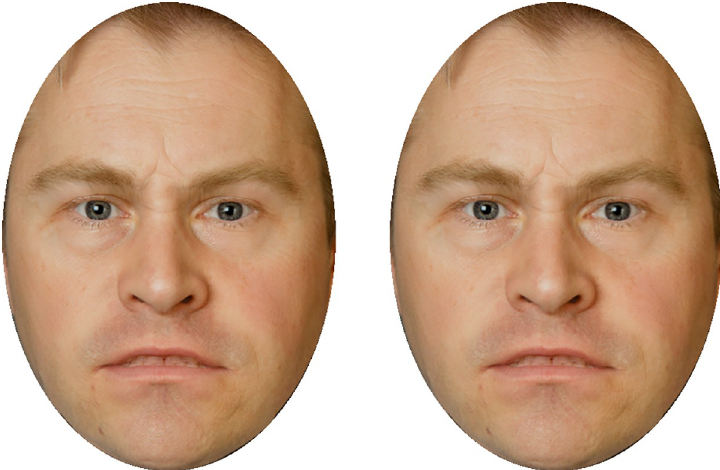
Fig 8. Demonstration of the magnitude of the modulation. 40 vs 45%, i.e. 5 morph-% difference in the intensity of emotional expression.